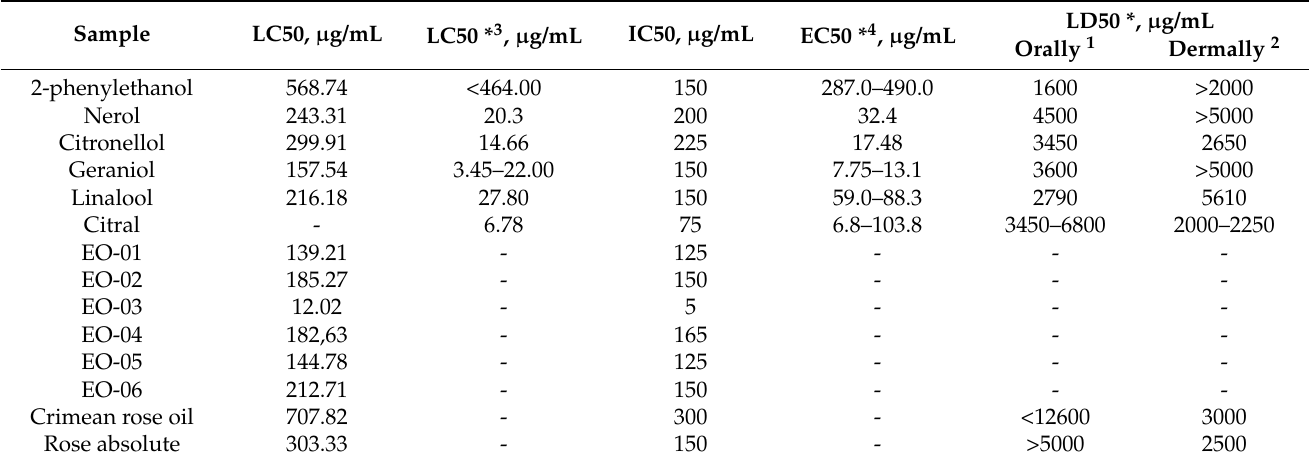
Table 4. In vitro toxicity parameters of Eremothecium and rose oils and their components (aromatic and monoterpene alcohols) (vs. in vivo * 1–4